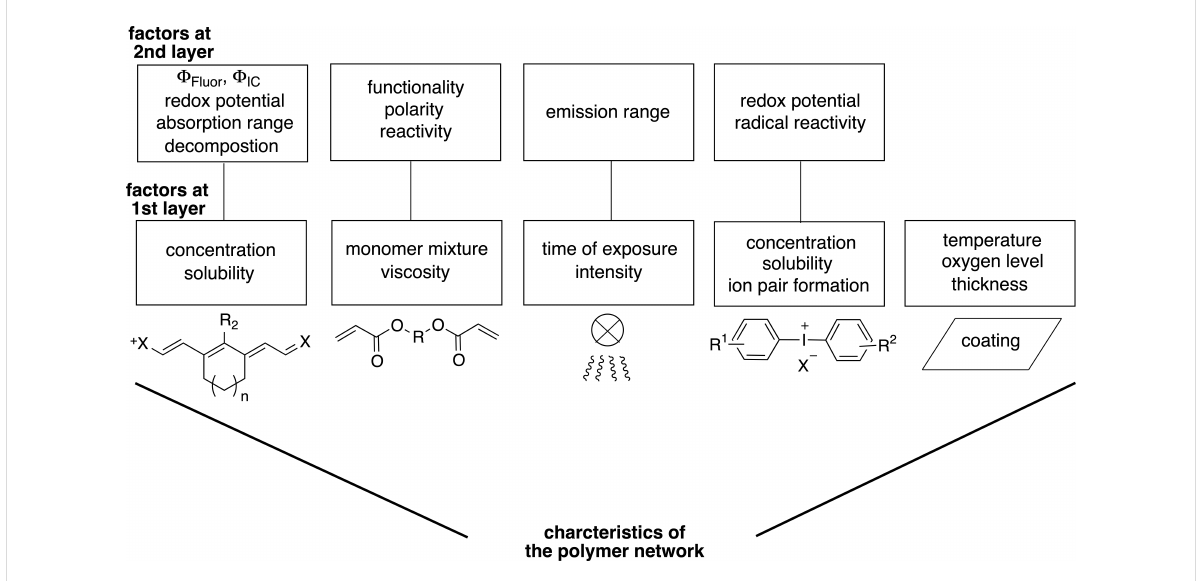
Scheme 15: Classification of the factors for the formation of polymer networks by NIR-photocuring depending on the absorber material, the mono- mers, parameters of the light source, the coinitiator and surrounding conditions. Each position consists of factors directly influencing the process and properties of the material chosen for the formulation at the 2nd layer. A digital twin created by data analysis using machine learning algorithms can describe the relation of the factors in